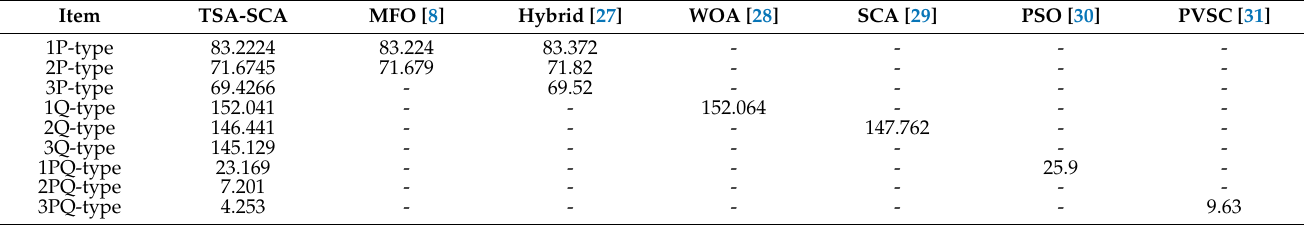
Figure 12. PV curves of the IEEE 69 ‐ node RDS system with 3 PQ ‐ type DG installations.